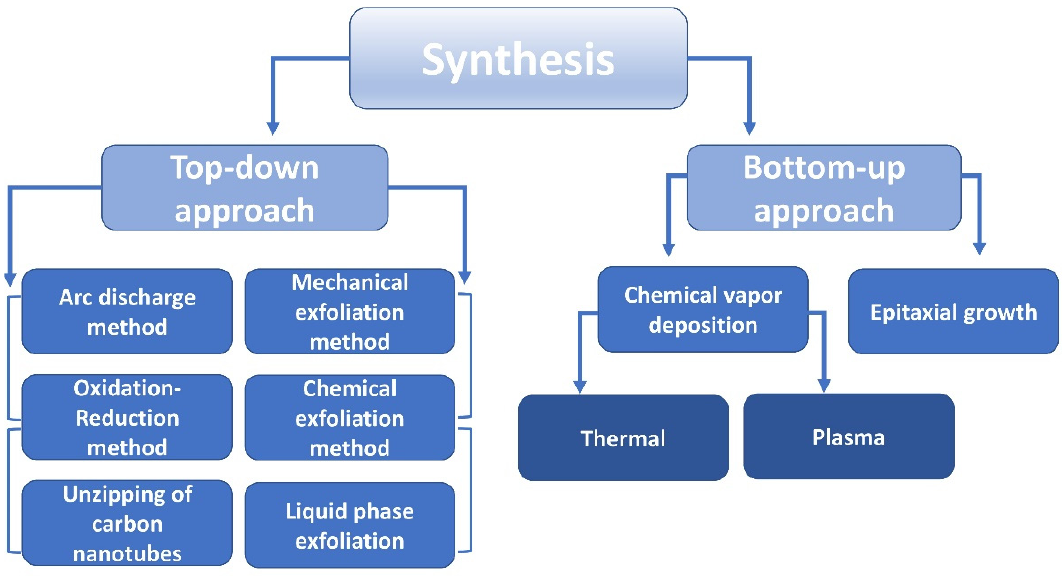
Figure 2. A process flow chart of Graphene synthesis [34].